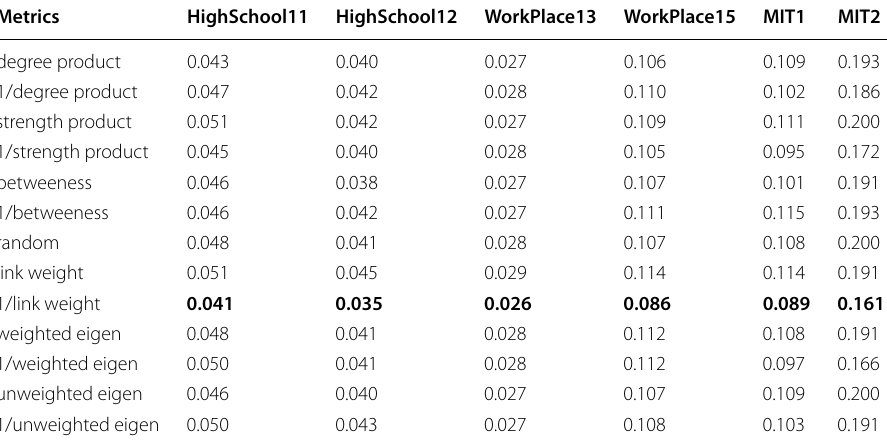
Table 7 The average prevalence E [ ρ ] when the recovery rate is γ = 0% per step and φ = 10% of the contacts are removed from each temporal network using removal probability (3) based on each centrality metric and f ( t ) = 1 t ≤ T / 2 + 4 · 1 t > T / 2 . Contacts occurring late in time i.e. t > T / 2 are more likely to be